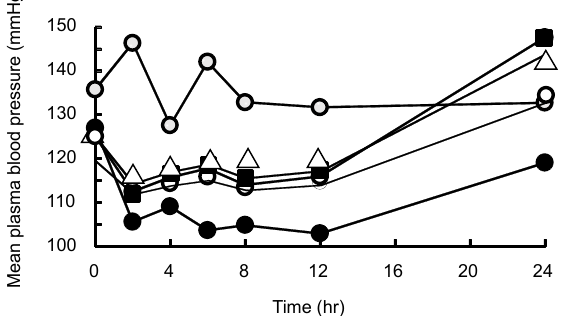
Figure 6. Mean plasma blood pressure profiles for control ( ● ), OLM suspension ( △ ), OLM/SD-CS/lactose ( ■ ), OLM/SD-CS/HP- β -CD ( ○ ), OLM/SD-CS/SBE- β -CD ( ● ) suspensions in rats (at OLM dose of 1 mg/kg). (OLM = olmesartan tablets, SBE- β -CD = sulfobutyl ether- β -cyclodextrin, and SD-CS = spray-dried chitosan).